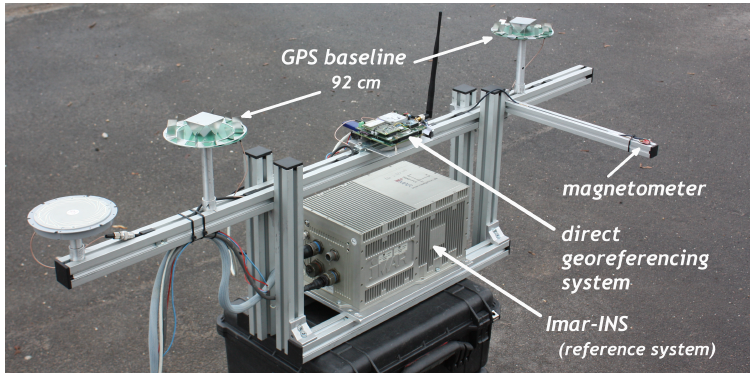
Figure 4. The measurement setup for the accuracy evaluation tests. This setup replicates the